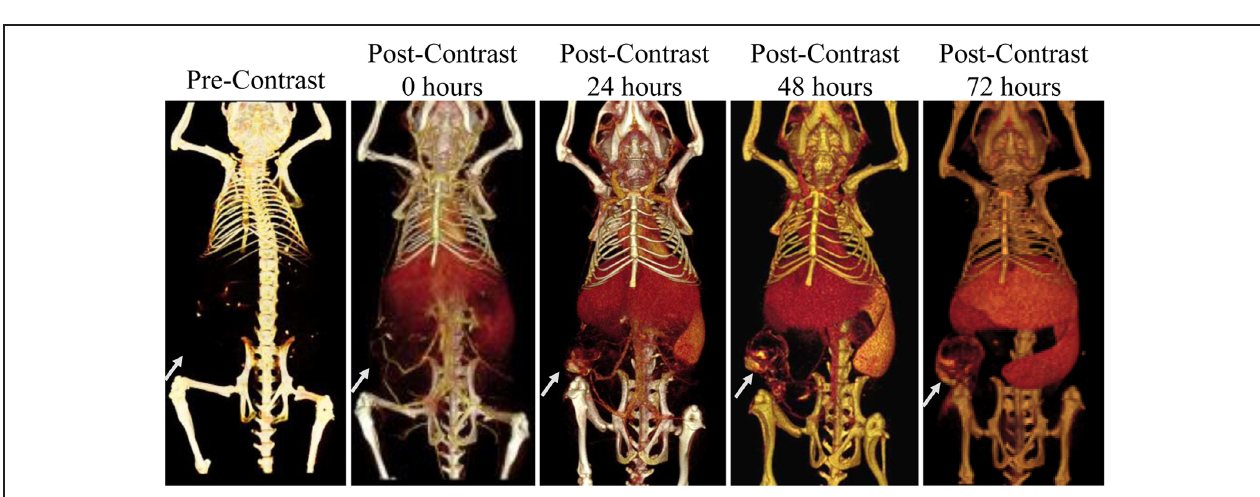
FIGURE 9 | Longitudinal micro-CT imaging of liposomal iodine biodistribution. Liposomes slowly accumulate in the subcutaneous tumor, liver, and spleen over the course of 72 h. The white arrow points to the location of the tumor in each image.